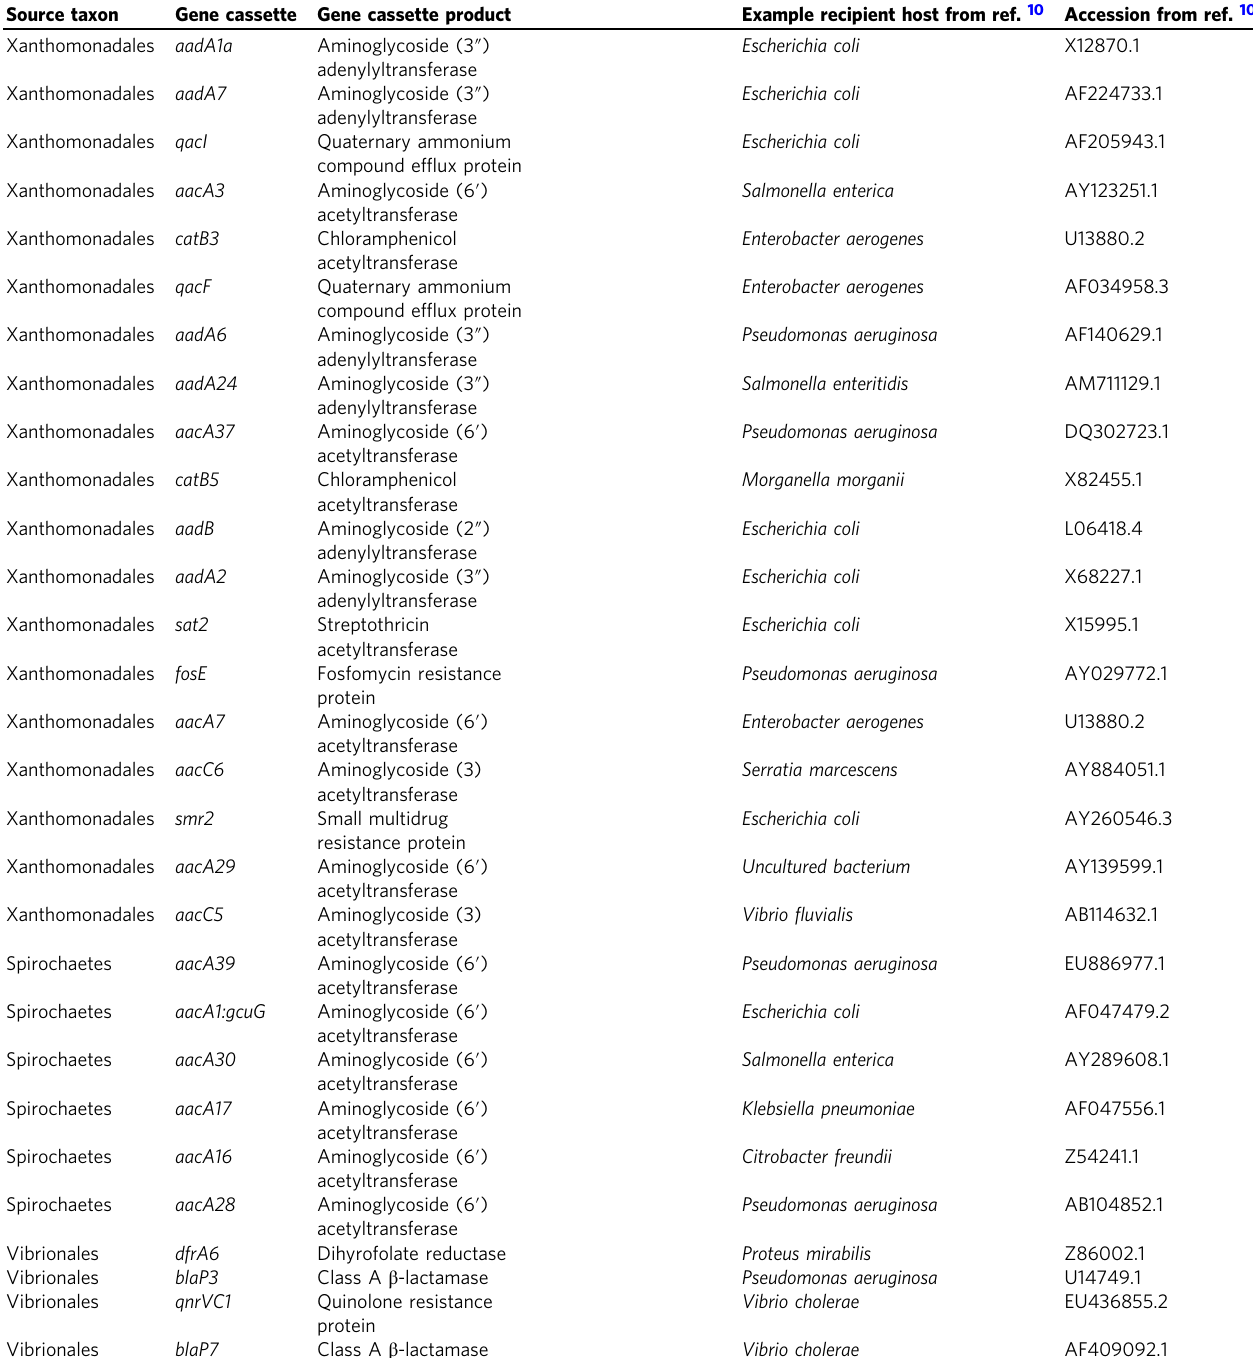
Table 1 Predicted taxonomic source of resistance gene cassettes found on mobile integrons. Source taxon Gene cassette Gene cassette product Example recipient host from ref. 10 Accession from ref.